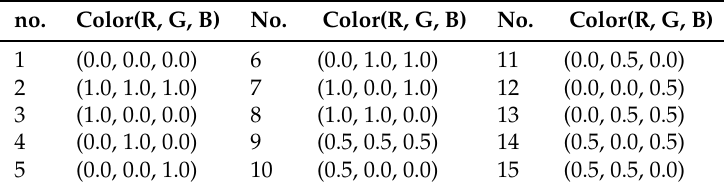
Table 1. Basic colors for monochrome UI.